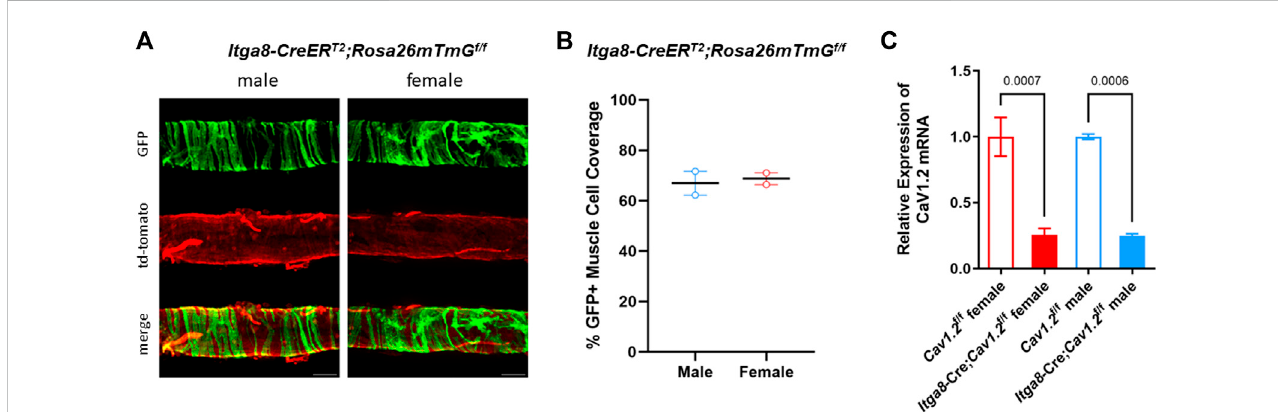
FIGURE 2 Evaluationofrecombinationef fi ciency. (A) ImagesofGFPandtd-tomatoexpressioninmaleandfemaleinguinal-axillarylymphaticsfrom Itga8-CreER T2 ; Rosa26mTmG f/f mice, showing recombination (GFP + cells) in the majority of lymphatic smooth muscle cells. (B) Summary of %GFP + cells in segments of 2 male and 2 female inguinal-axillary lymphatics from Itga8-CreER T2 ; Rosa26mTmG f/f mice. (C) Expression of Cav1.2 mRNA relative to β -actin from inguinal- axillary vessels of 3 male and 3 female Cav1.2 f/f mice and 3 male and 3 female Itga8-CreER T2 ;Cav1.2 f/f